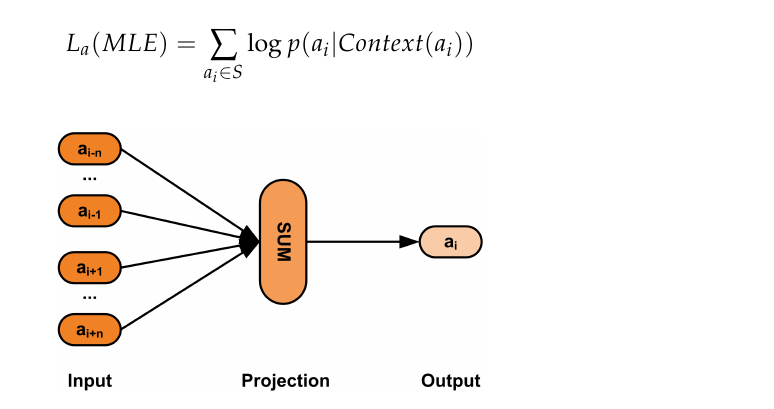
Figure 2. Representation of actions as